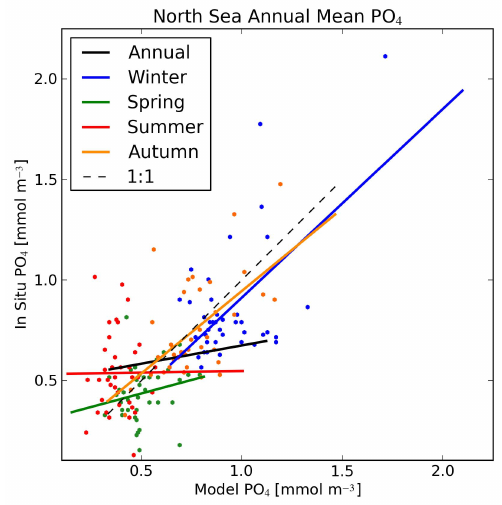
Fig. 7. Two-dimensional scatter plot of annual mean matched model data against in situ measurements for the North Sea nitrates. The solid coloured lines show the linear regression fits for the annual and seasonal annual means data, and the dashed line is the line of unity slope that passes through the origin. The matched seasonal means are shown as colour-coded scatter points.